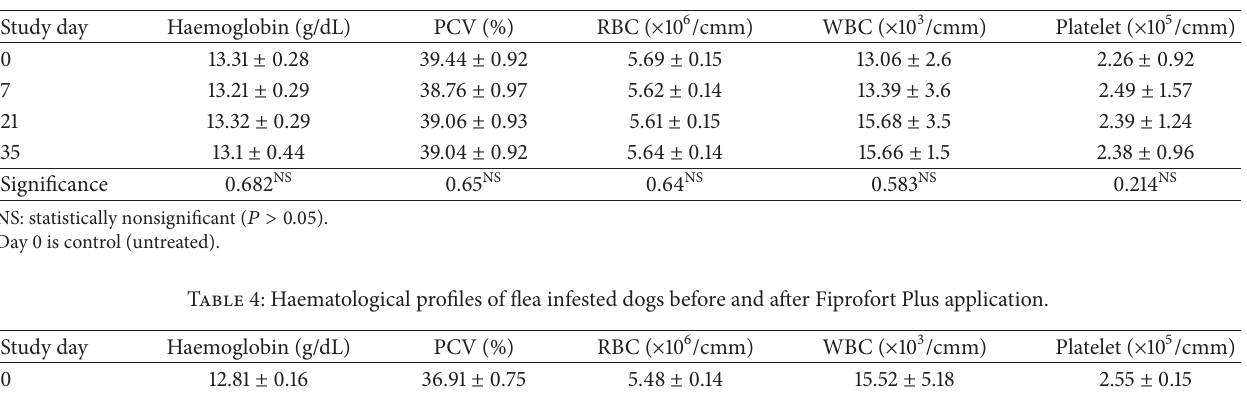
Table 3: Haematological profiles of tick infested dogs before and after Fiprofort Plus application.